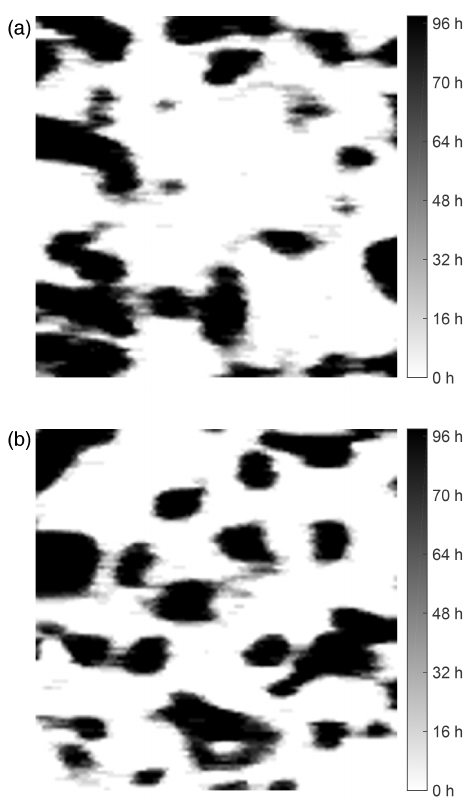
Figure 5. Residence time of ice particles within in a slice (5 . 7mm × 5 . 7mm) parallel to the flow direction for (a) “sa3” and (b) ) “sa4” by overlapping time-lapse tomography pictures. The period of 8h was sufficiently short to calculate the residence time of each ice voxel with an uncertainty of 6%.